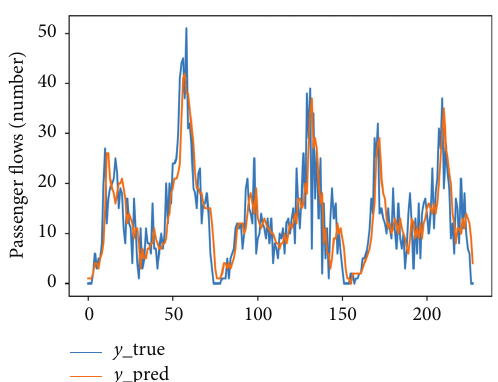
Figure 12: Regression integration prediction results when the time step is 3h.